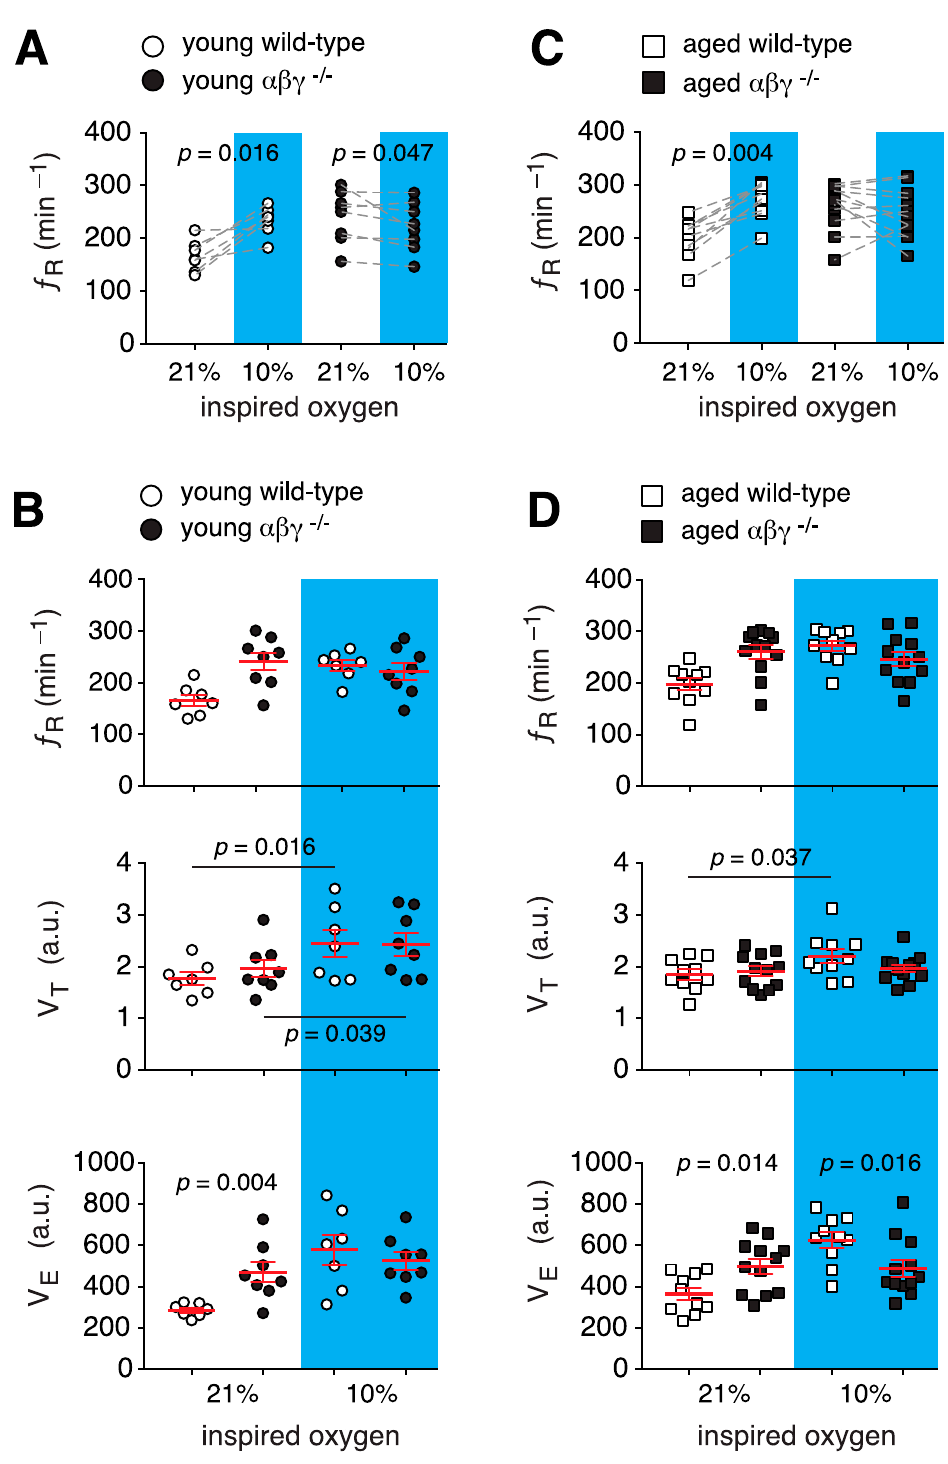
Figure 2. Respiratory responses of αβγ − / − mice to hypoxia. ( A , B ) Group data from whole-body plethysmography measurements of respiratory rate (ƒ R ), tidal volume ( V T ), and minute ventilation ( V E ) of unrestrained young wild-type and αβγ − / − mice in room air (21% O 2 ) and moderate hypoxia (10% O 2 ). ( C , D ) Summary data from whole-body plethysmography measurements of breathing parameters (ƒ R , V T , V E ) of aged wild-type and αβγ − / − mice in 21% and 10% O 2 . p —Wilcoxon matched-pairs signed-rank test ( A , C ), middle panels in ( B , D ); Mann–Whitney U rank test (lower panels in ( B , D )).